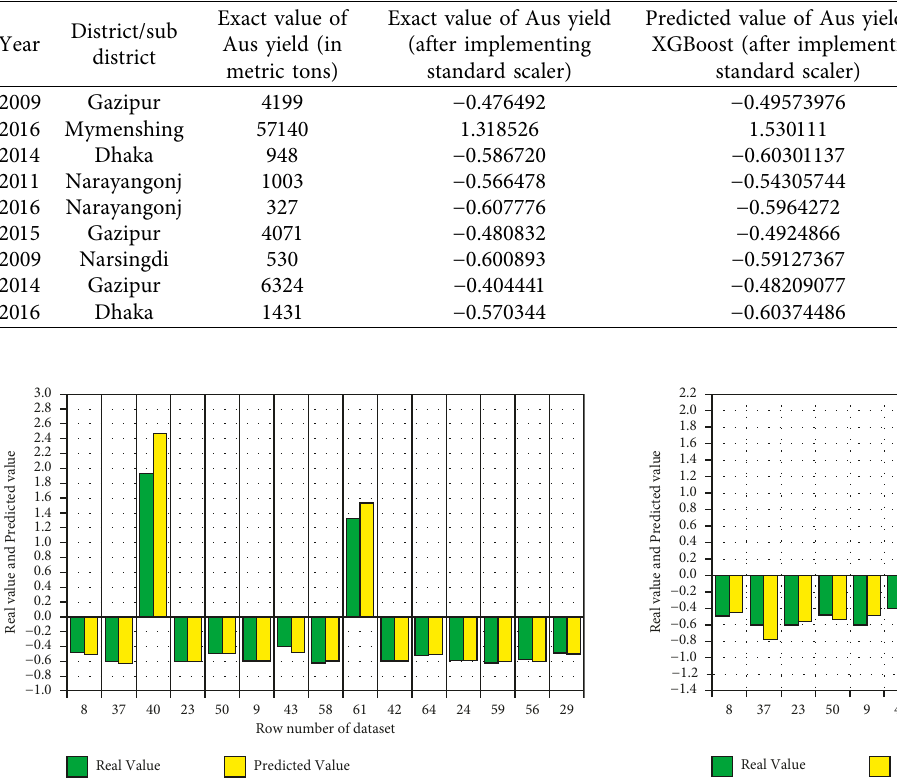
Figure 9: Comparison between Real Values and Predicted Values of Aus yield for SVR.